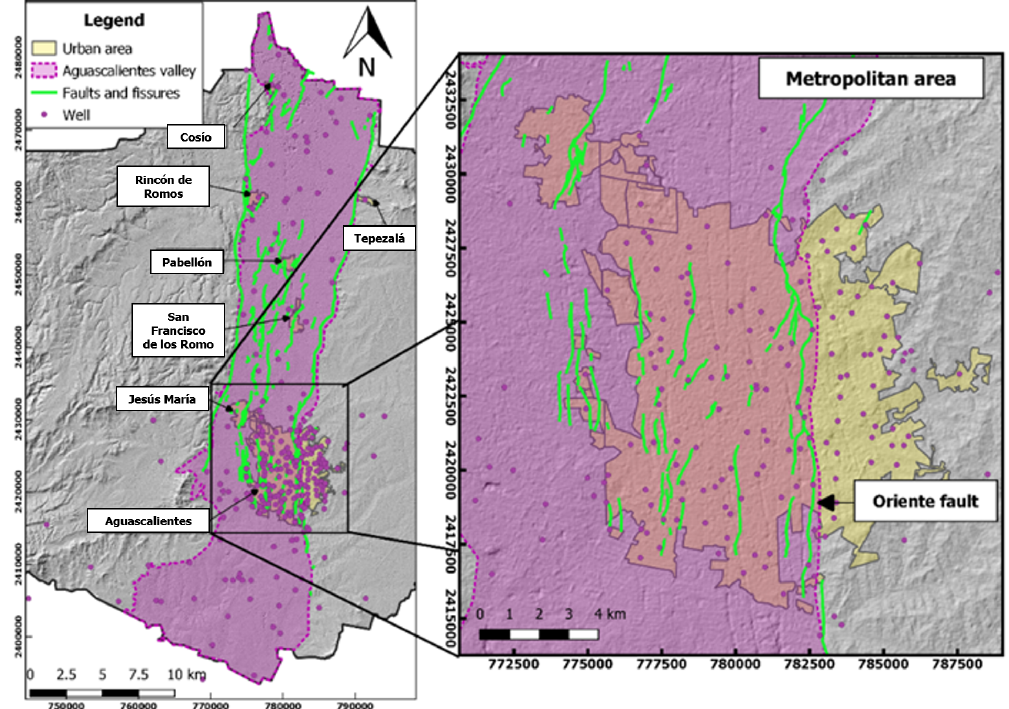
Figure 1. System of faults and fissures and the location of production wells for the Aguascalientes valley (SIFAGG, 2017; Conagua,